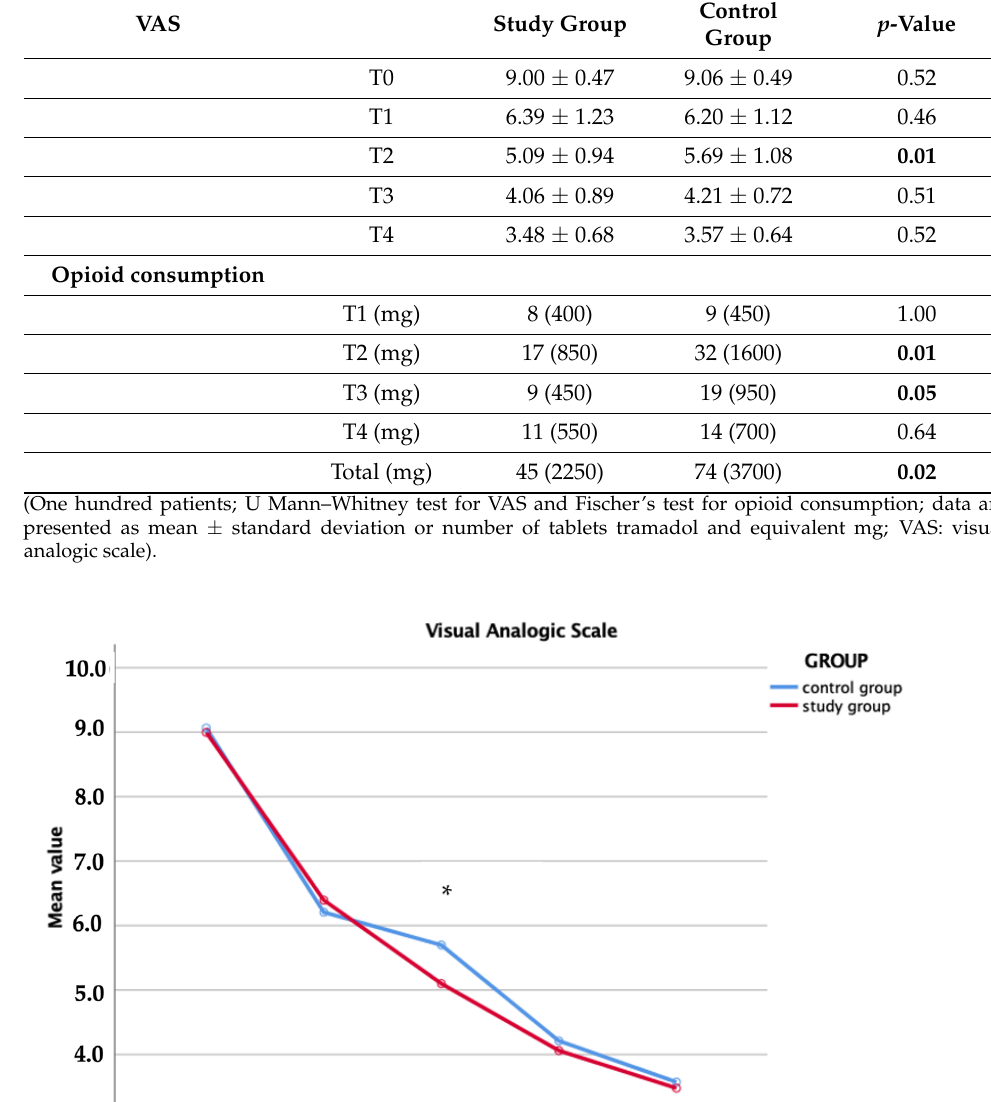
Table 2. Differences in pain and opioid treatment between groups. VAS Study Group